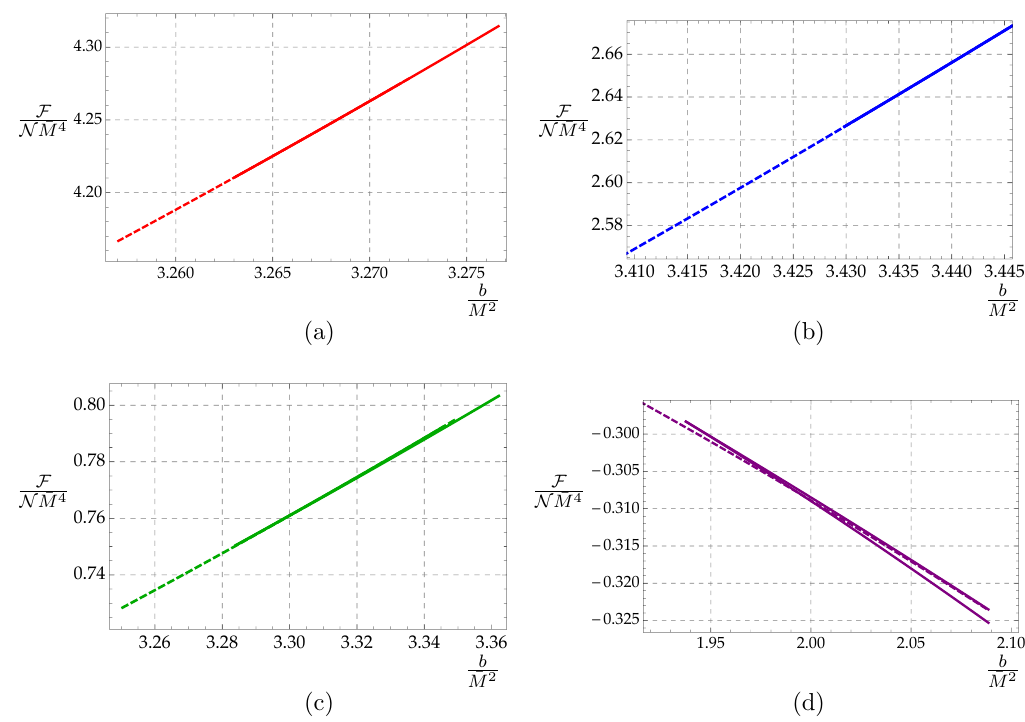
Figure 10 . Zoom into the transition region between Minkowski and black hole embeddings for the free energy density. The values of the temperature are T= (cid:22) M = 0.55 (a), 0.59 (b), 0.65 (c), and 0.734 (d). Dashed lines represent Minkowski embeddings, whereas solid lines represent black hole embeddings.